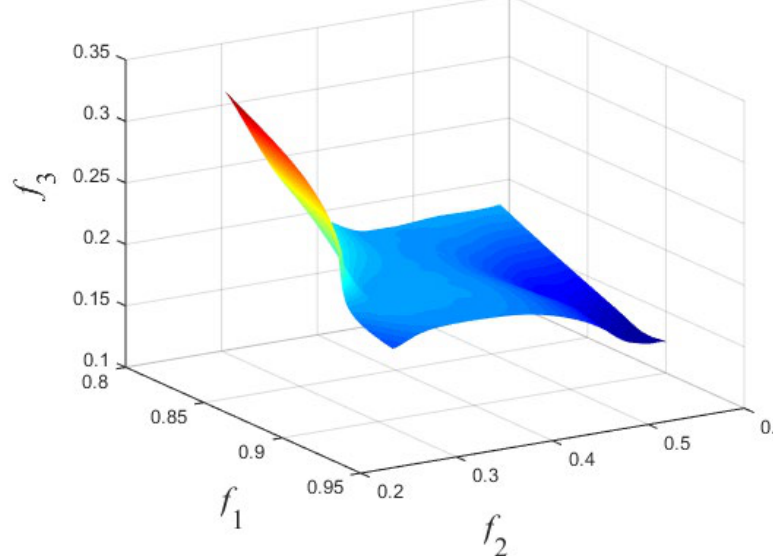
Figure 19. Pareto optimal solution set.